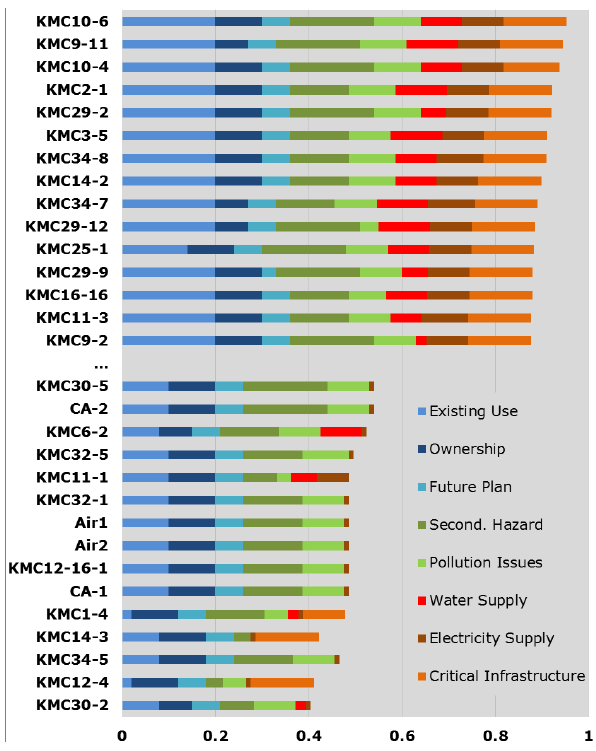
Figure 3. The first and last 15 open spaces ranked according to the suitability